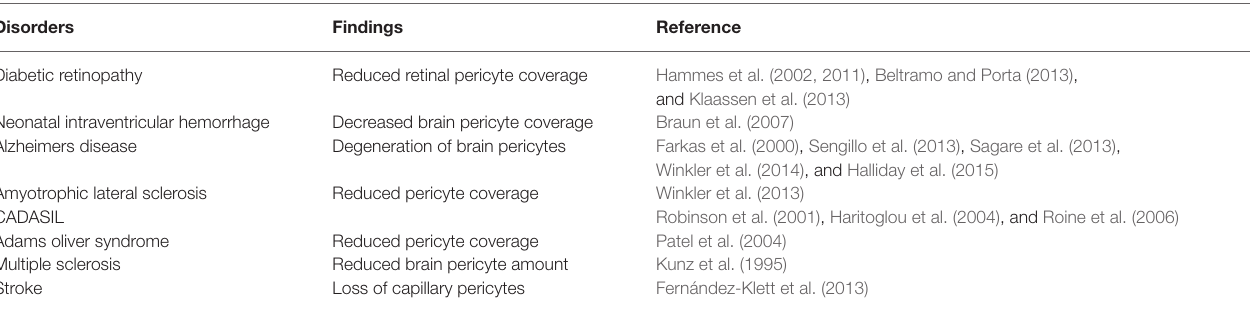
TABLE 2 | Excerpt of diseases with associated pericyte dysfunction